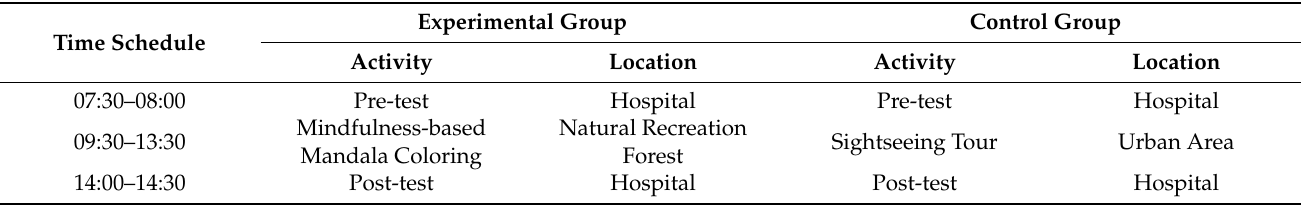
Table 1. Time schedule of experimental